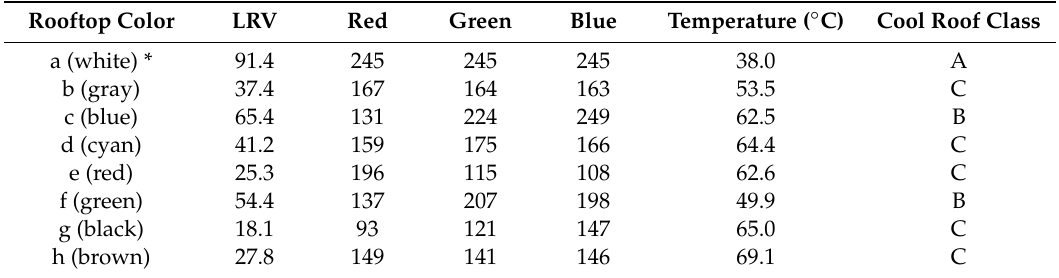
Table 3. Comparison between LRV and temperature according to rooftop